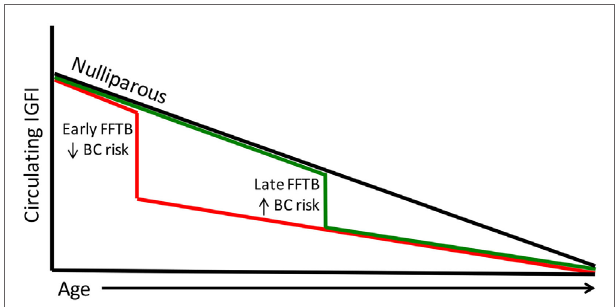
FiGURe 1 | Circulating iGFi levels parallel breast cancer risk . Circulating IGFI levels are lower in parous women compared to nulliparous women (black line). A FFTB at an early age (red line) reduces IGFI sooner, foregoing the excess circulating IGFI that women who become pregnant for the first time later encounter (green line). This parallels the data on breast cancer risk, with women who undergo a late FFTB displaying an increased breast cancer risk compared to those who undergo an early